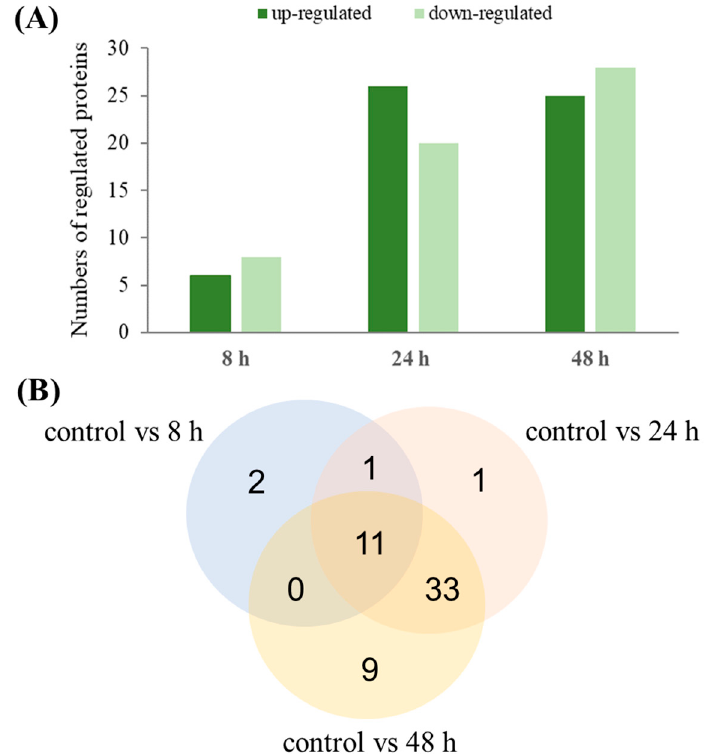
Figure 3. Number of significantly di ff erentially expressed proteins in Pseudomonas putida KT2440 during mcl-PHAs synthesis. ( A ) Number of up-regulated and down-regulated genes at 8 h, 24 h, and 48 h of the cultivation compared to the control. ( B ) Venn diagram showing the numbers of common and specific di ff erentially expressed proteins during mcl-PHAs synthesis.